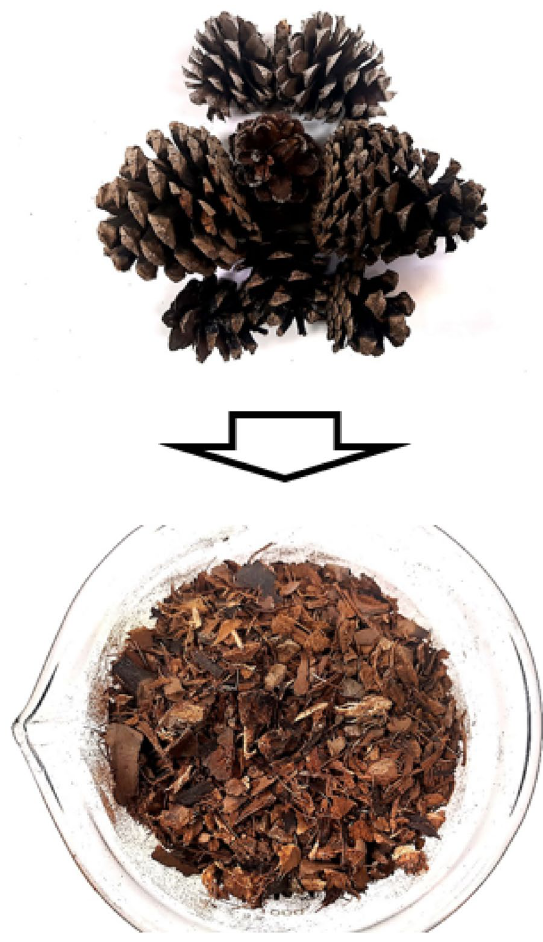
Fig. 1 Preparation of pine cone particle